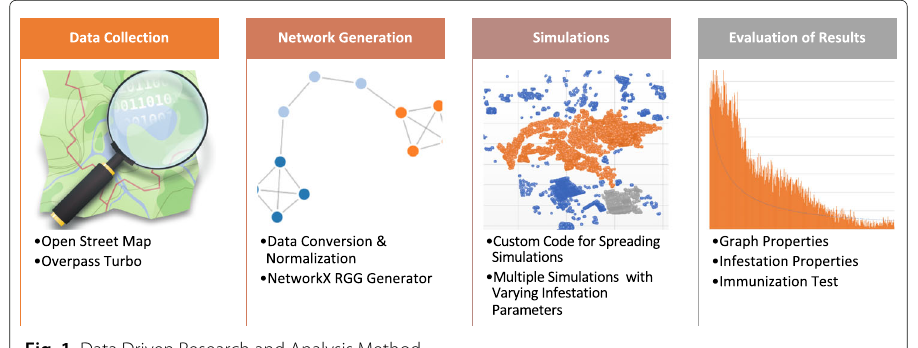
Fig. 1 Data Driven Research and Analysis